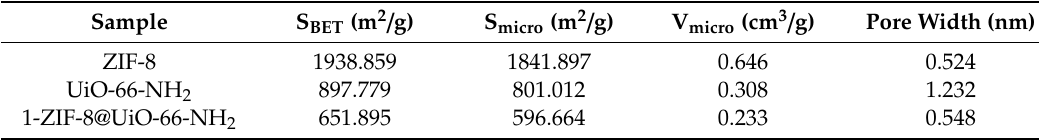
Figure 4. ( a ) N 2 adsorption / desorption isotherms at 77K (The illustration is pore size distribution). ( b ) Thermogravimetric analysis (TGA) and Derivative Thermogravimetry (DTG) curves for UiO-66-NH 2 and zeolitic imidazolate framework-8 (ZIF-8)-loaded UiO-66-NH 2 . Table 1. Pore structure parameters of zeolitic imidazolate framework-8 (ZIF-8), UiO-66-NH 2 , 1-ZIF-